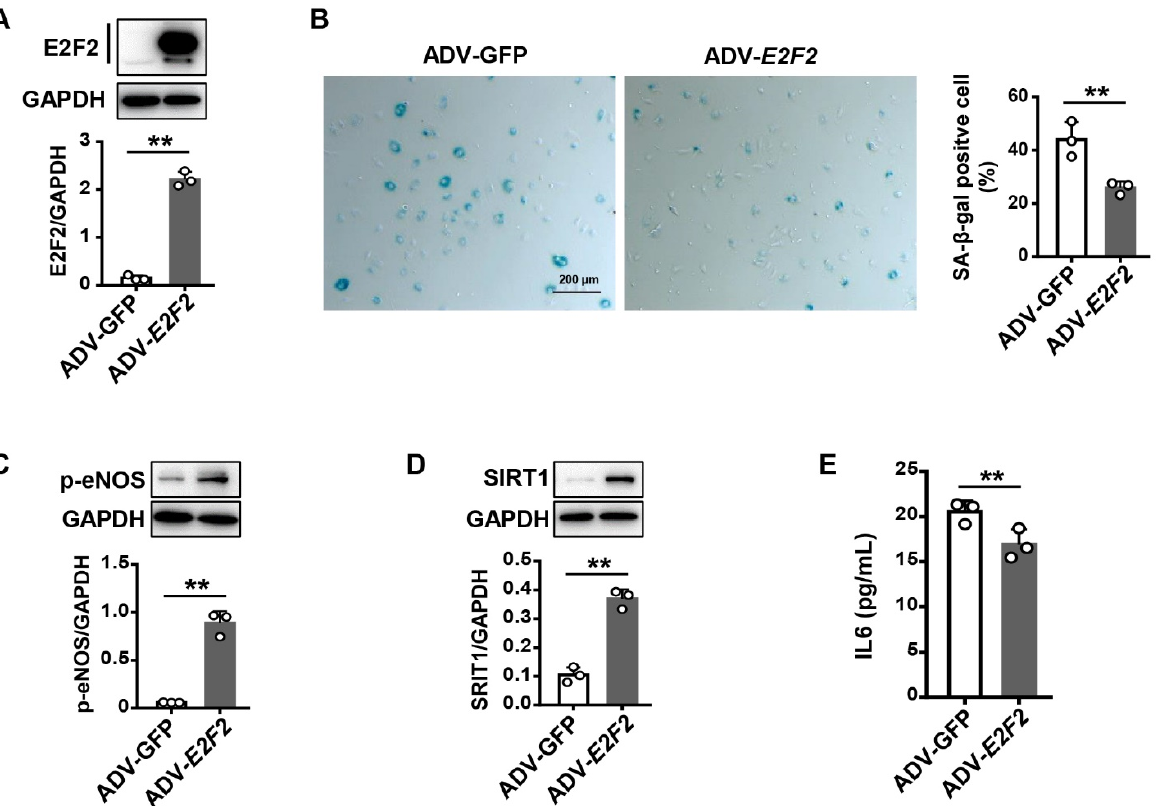
Figure 4. Rescue of endothelial cell senescence in E2F2 -overexpressed HUVECs (PDL36). ( A ) Western blot analysis for HUVECs transfected with ADV- E2F2 . ADV-GFP as a control. ( B ) SA- β -gal staining (blue) for HUVECs transfected with ADV- E2F2 . Scale bar: 200 µ m. Protein expression of p-eNOS ( C ) and SIRT1 ( D ) in HUVECs transfected with ADV- E2F2 . ( E ) ELISA for the IL6 level in the conditioned medium of E2F2 -overexpressed cells. Student’s t test for statistical analysis. Values are mean ± S.D. ** p < 0.01.